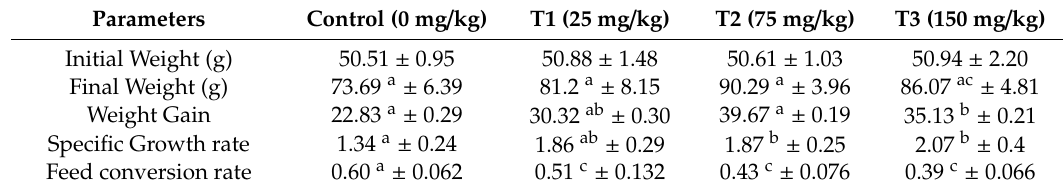
Table 1. E ff ect of methanol extract of Chaetomorpha antennina on the growth response in Labeo rohita .